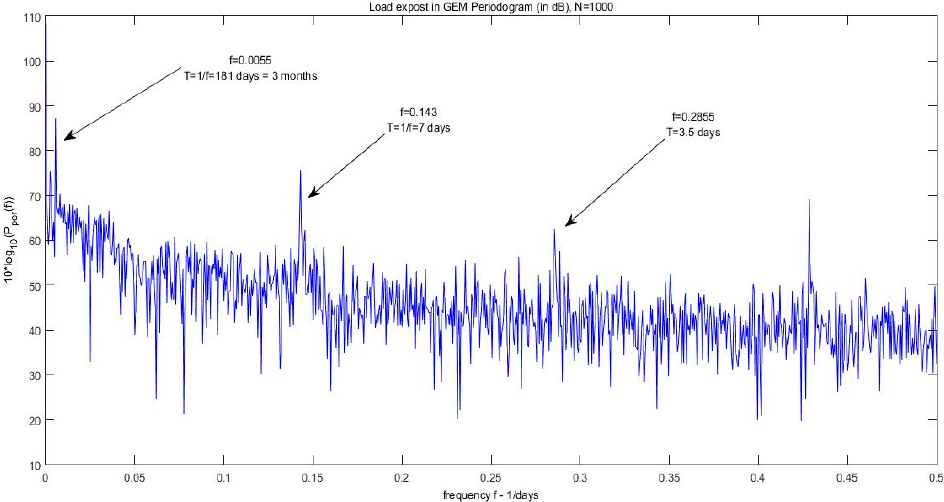
Figure 8. Periodogram of daily average load in the frequency domain.